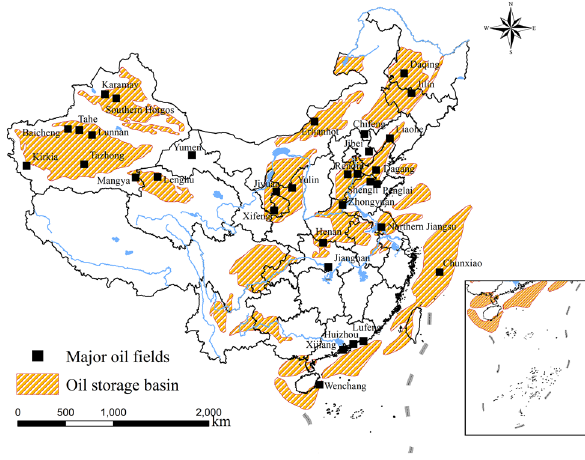
Fig. 2 The statistical distribution of petroleum